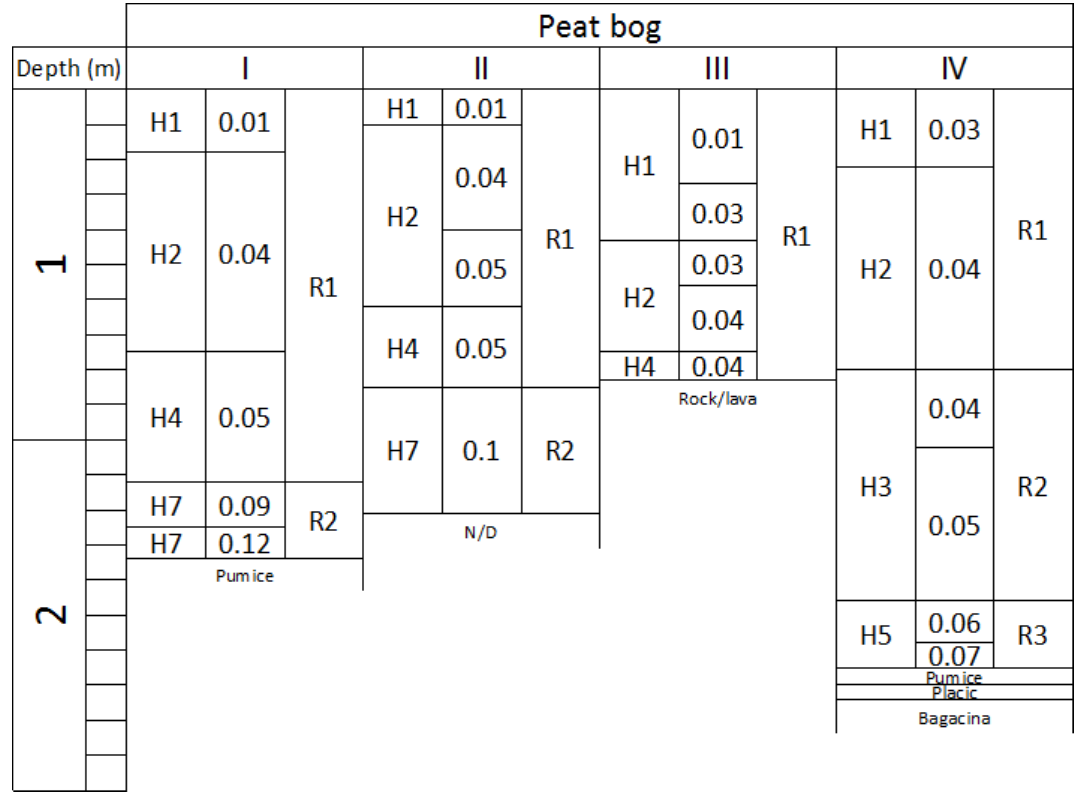
Figure 4. Depth and classification of layers identified in the profiles of the studied bogs. according to the von Post scale (Paavilainen & Pӓivӓnen 1995) (H1 to H3 - fibrous or white peat, H4 to H6 - hemic or dark peat, H7 to H10 - sapric or black peat), BD (g cm -3 ), and identified reflectors in the radargrams (R = reflector).